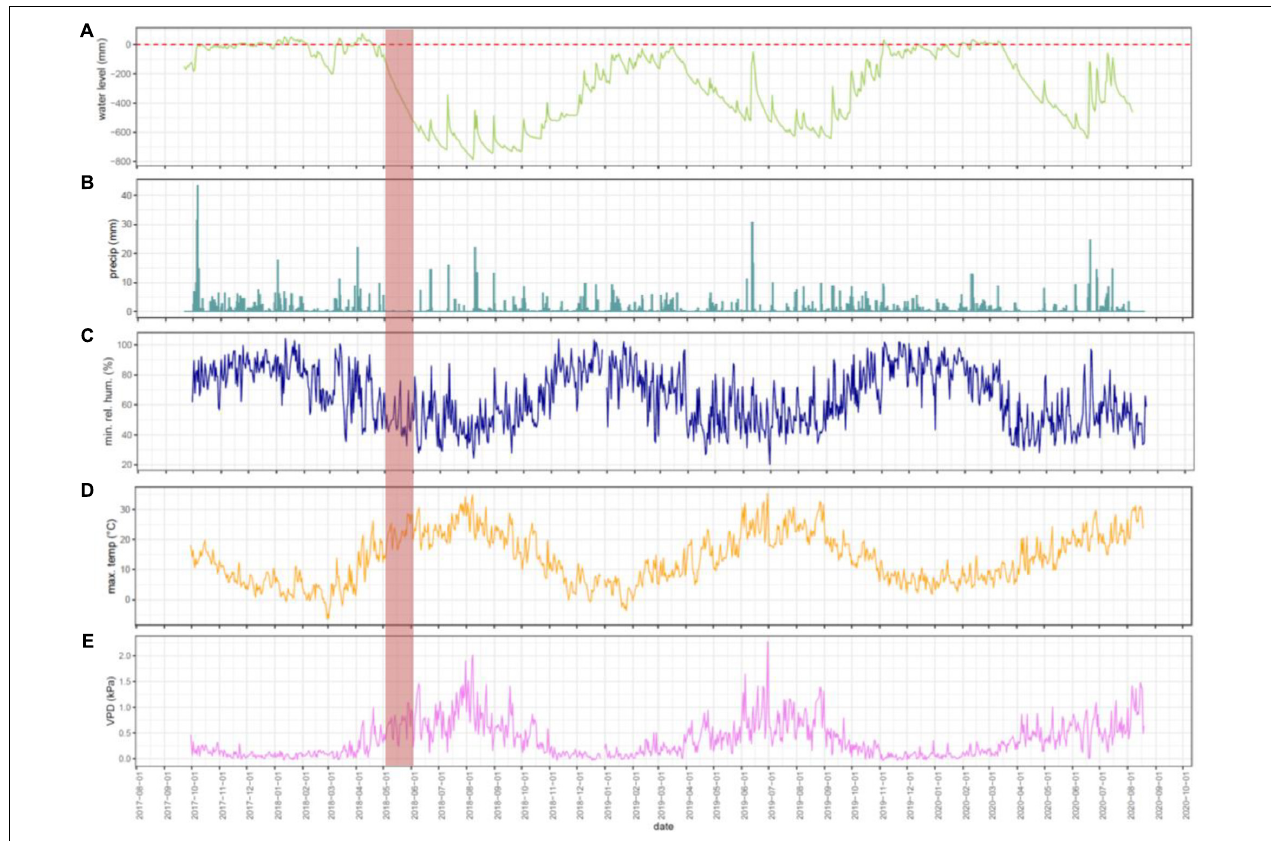
FIGURE 4 | Daily time series of (A) water level (B) precipitation (C) minimum relative humidity (D) maximum air temperature (E) mean vapor pressure deficit at PD. Dashed lines in panel (A) represent the peat surface while positive values indicate aboveground and negative values indicate belowground. An example of rapid water level decline during high maximum daily air temperatures and absence of substantial rainfall is indicated by the translucent pink